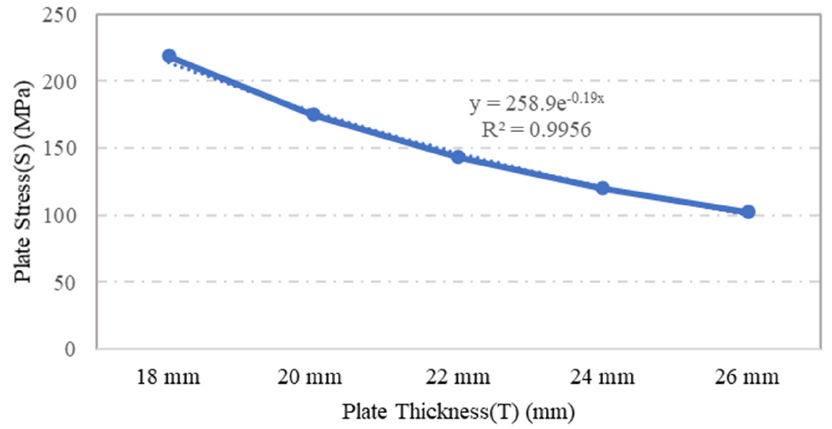
Figure 8. Influence of plate thickness on the plate maximum stress.